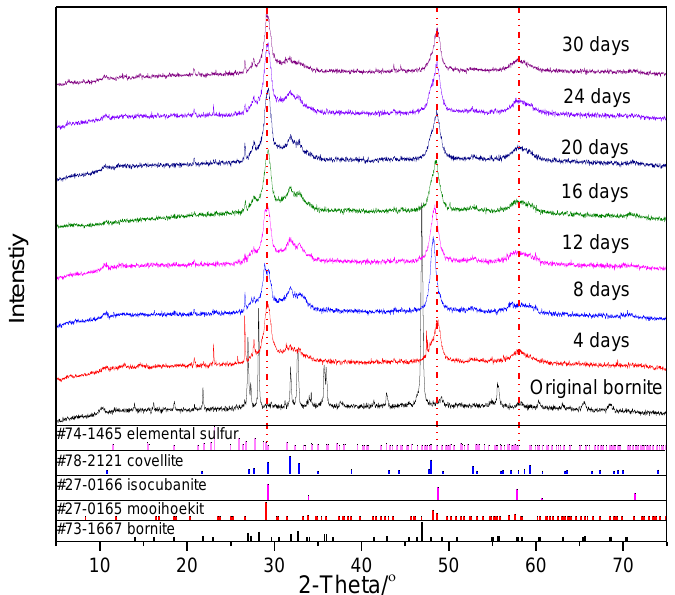
Figure 8. X-ray powder diffraction analysis leached residues by A.caldus.